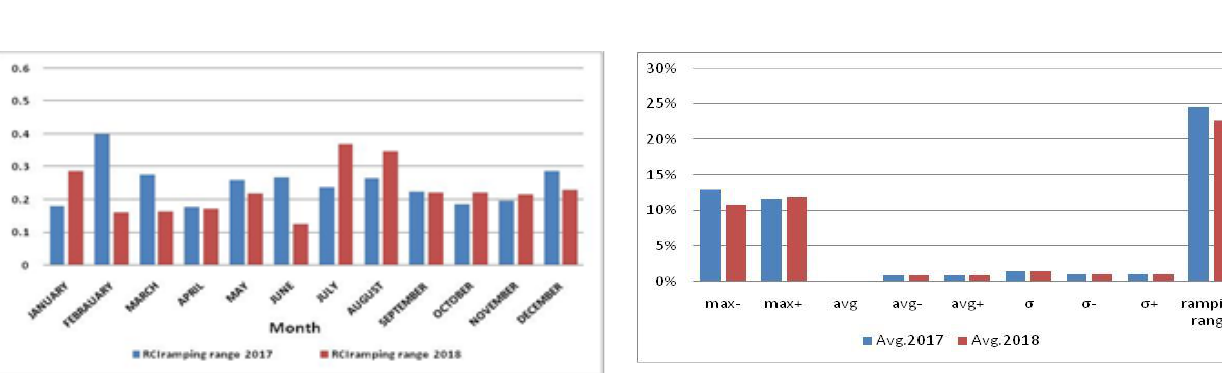
Figure 39. Average values of horizontal analysis results by